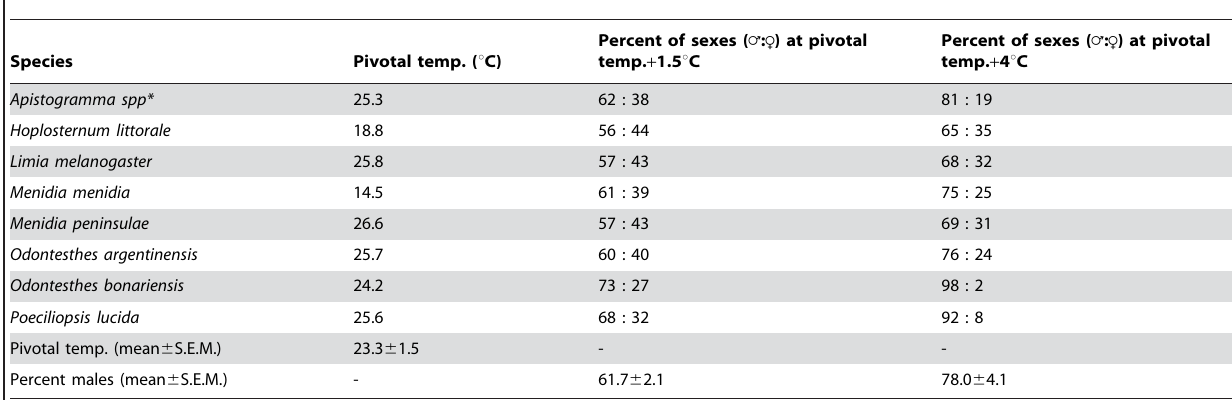
* Average of the 33 species shown in Table S1.